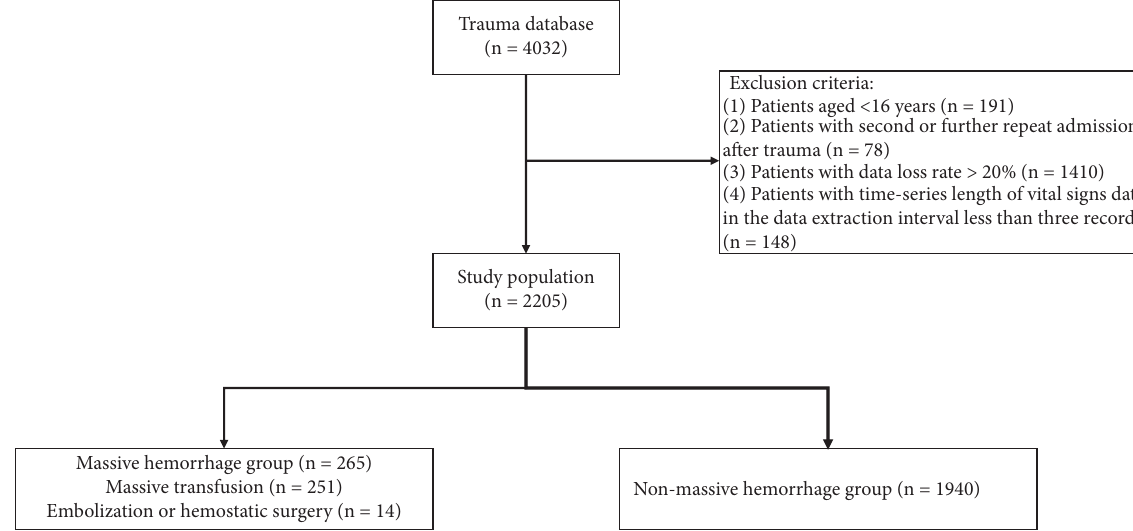
Figure 1: Patient selection fow